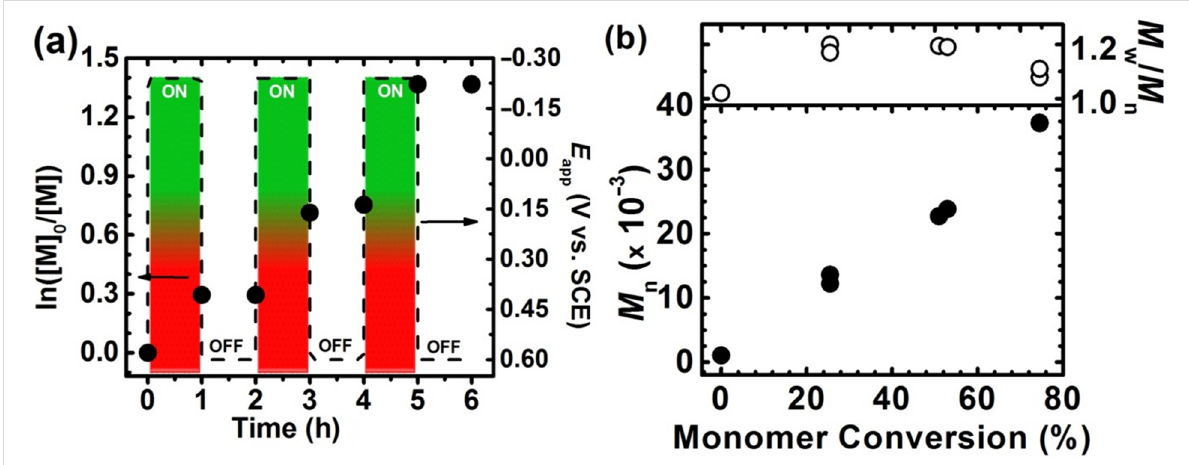
Figure 3: (a) First-order kinetic plot of se ATRP with periodically applied different values of potential, between − 240 mV and 600 mV vs SCE, respec- tively; and (b) M n and M w / M n with respect to monomer conversion. Reaction conditions are identical to those stated in Figure 2.